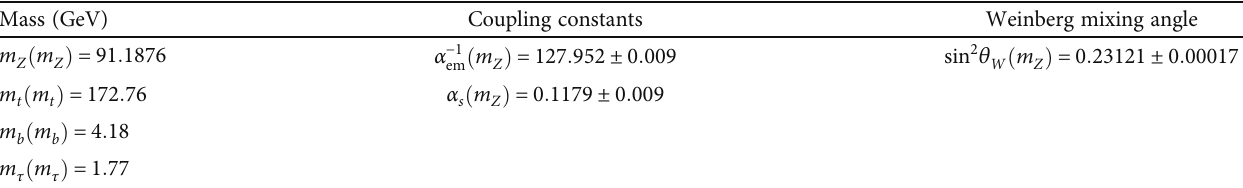
Table 1: Latest experimental data for fermion masses, gauge coupling constants, and Weinberg mixing